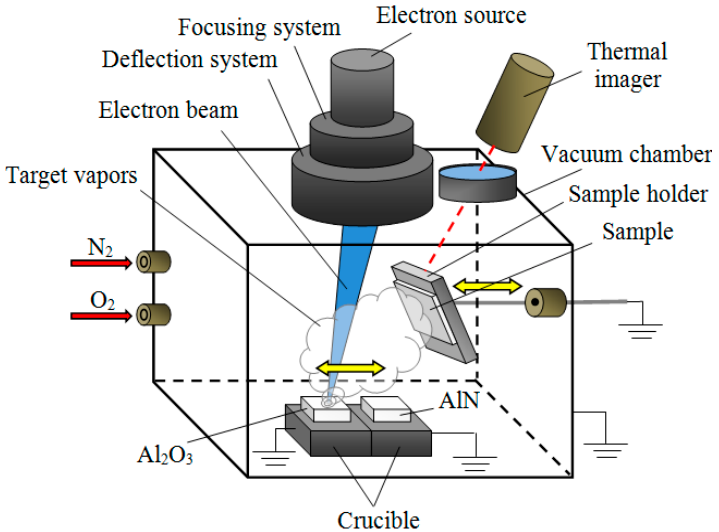
Figure 1. Experimental setup for coatings deposition on a microelectronic device.